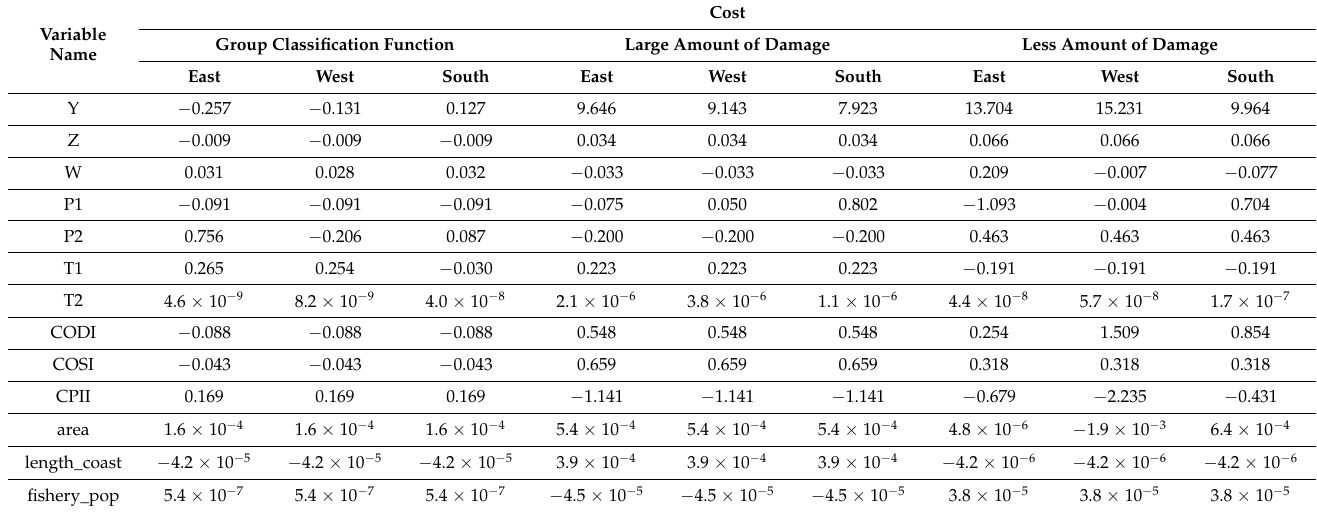
Table 3. Regression coefficient and the intercept value of the group damage prediction function.